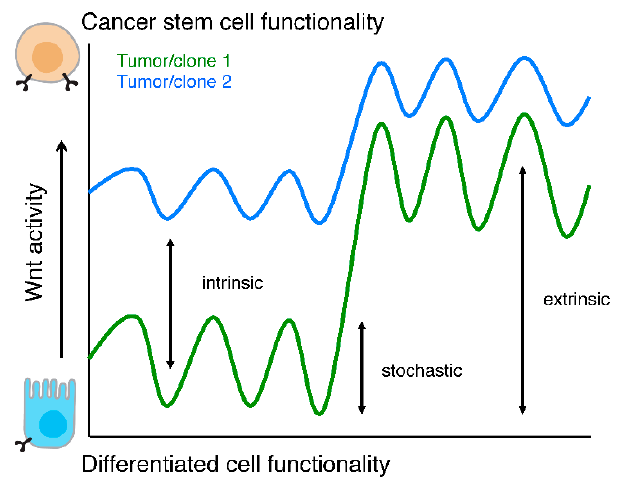
Figure 3. Wnt activity levels and functionality. Schematic representation of cellular functionality as a function of Wnt activity levels. Two tumors or clones are depicted (green and blue lines) to highlight that intrinsic Wnt activity levels, stochastic fluctuations, and responses to extra cellular stimuli are different between two (epi)genetically distinct populations.